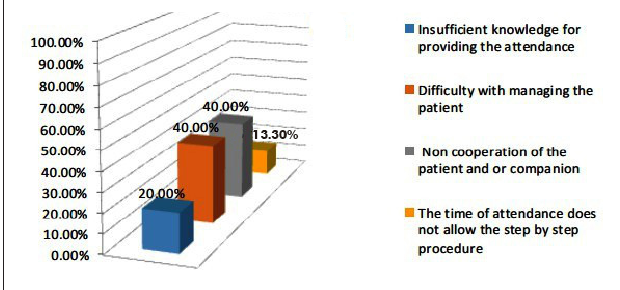
Fig. 3. Difficulty with attending to patients with DS. Source: Direct Research Parnaíba